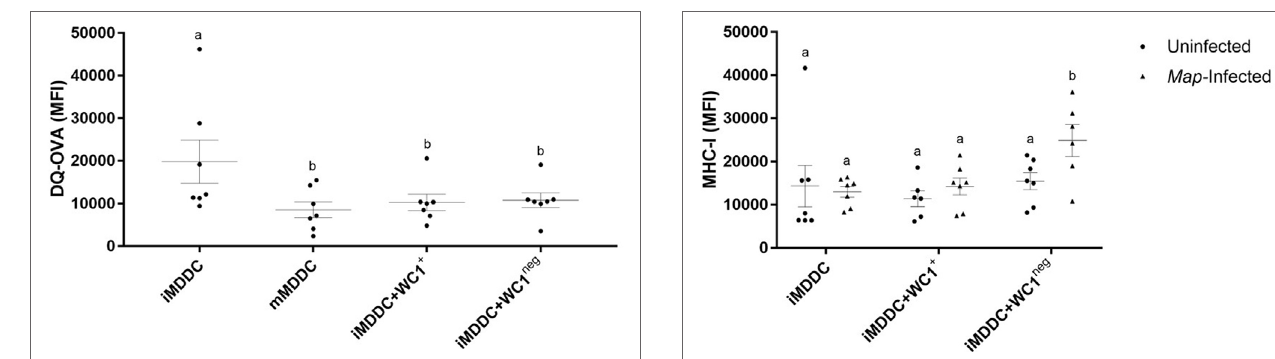
FigUre 6 | γδ T lymphocytes induce monocyte-derived dendritic cell (MDDc) maturation . DQ-ovalbumin endocytosis assay on immature MDDC (iMDDC), mature MDDC (mMDDC), iMDDC + WC1 + , and iMDDC + WC1 neg . iMDDC + WC1 + and iMDDC + WC1 neg had a reduction in their phagocytic ability in the same proportion as mMDDC. Results are individual animal data points and means ± SEM of seven animals. Different letters indicate statistically significant difference ( p <